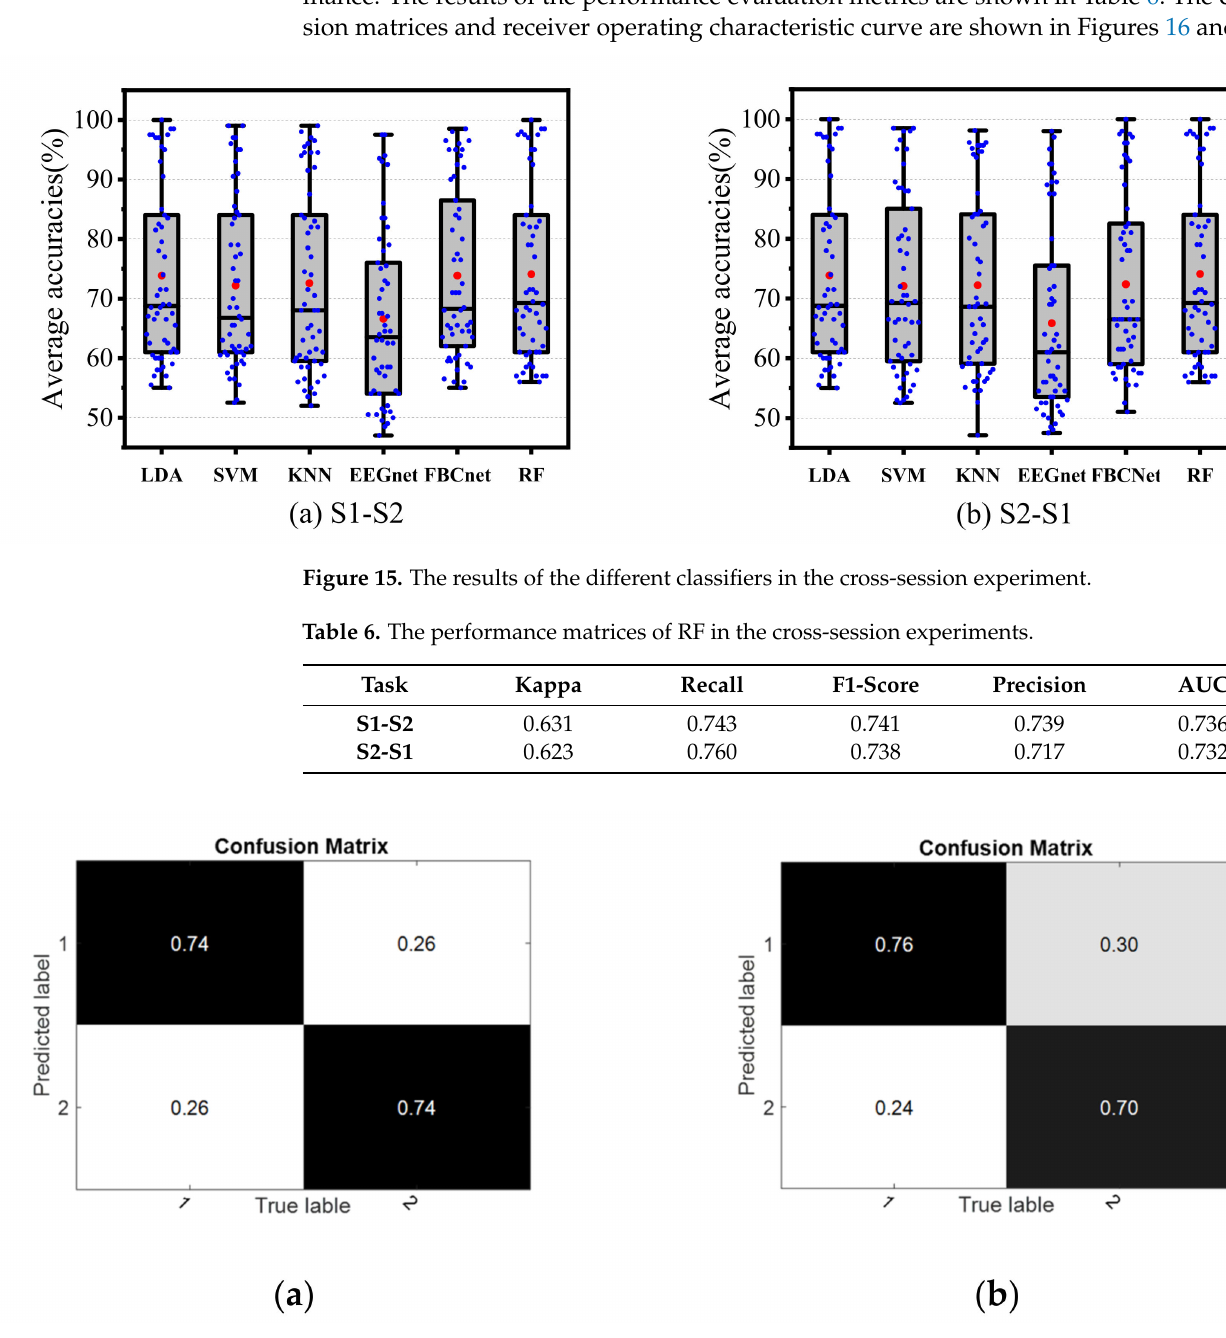
Figure 16. The confusion matrices of RF in the cross-session experiment. ( a ) S1-S2; ( b )